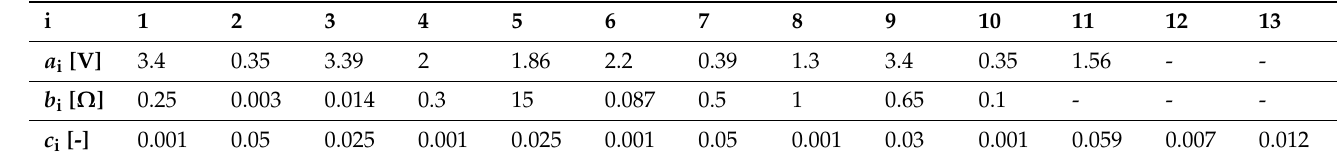
Table 1. Values of the parameters occurring in Formulas